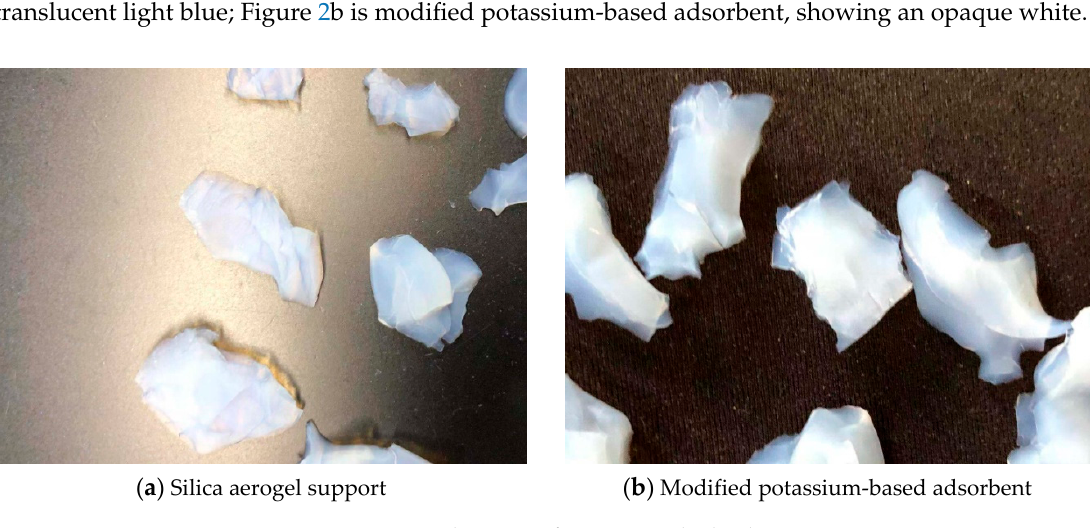
Figure 2. Actual images of support and adsorbent.